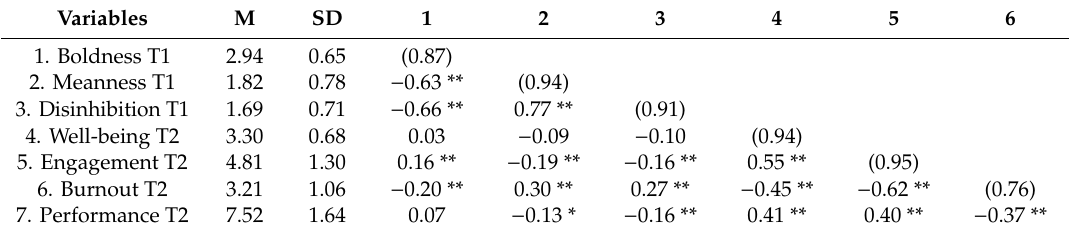
Table 5. Descriptive statistics for Sample 2 (employees, matched Time 1 and Time 2 data) ( N = 318).